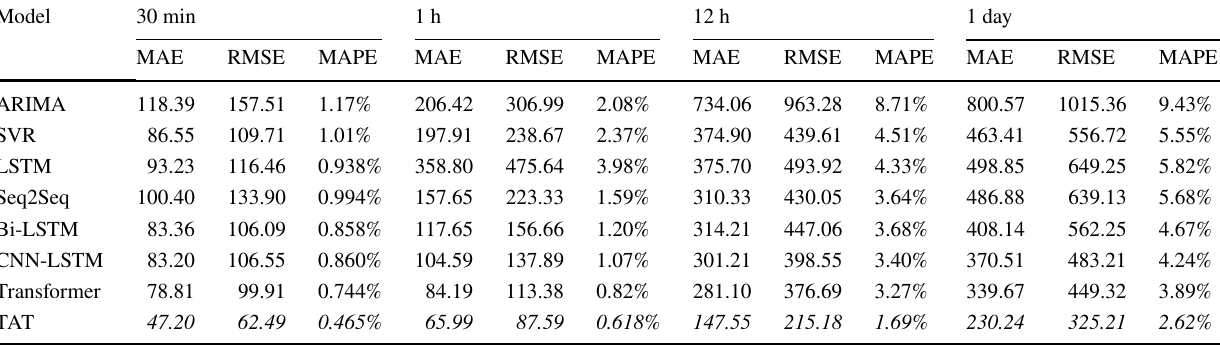
Italic values are the best results on traditional and deep neural